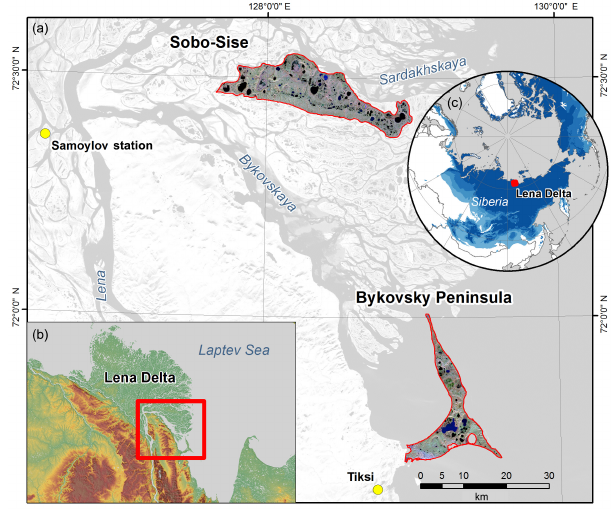
Figure 1. (a) Location of the two study areas in the Lena River delta region, Sobo-Sise Island, and Bykovsky Peninsula (Landsat 5 satellite image, acquisition date: 19 September 2009). (b) The Lena Delta region with a digital elevation model (ESA DUE-Permafrost DEM, Santoro and Strozzi, 2012), and (c) overview map including the permafrost zonation in Siberia (after Brown et al.,